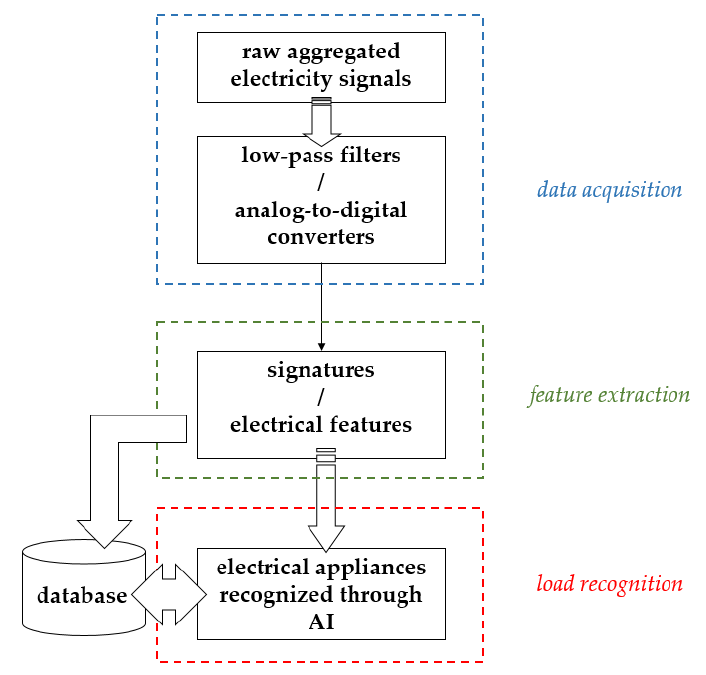
Figure 1. A basic NIALM process (profiling concerned electrical appliances and statistically computing base load should be done beforehand).